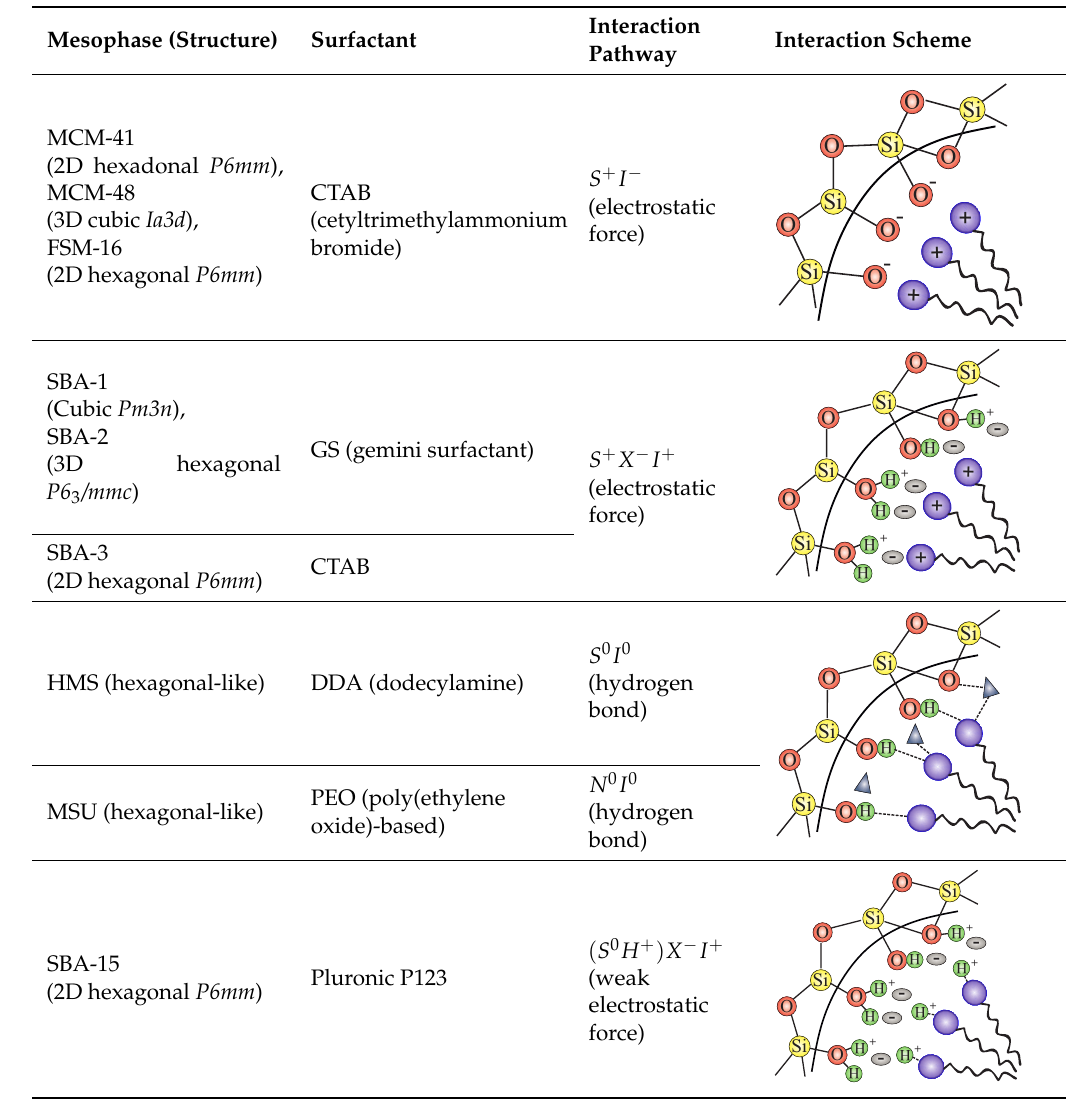
Table 1. Example types of mesoporous materials with different interactions between the surfactant and the inorganic framework. (Notation: S , N —a surfactant, I —an inorganic precursor, X —a counter